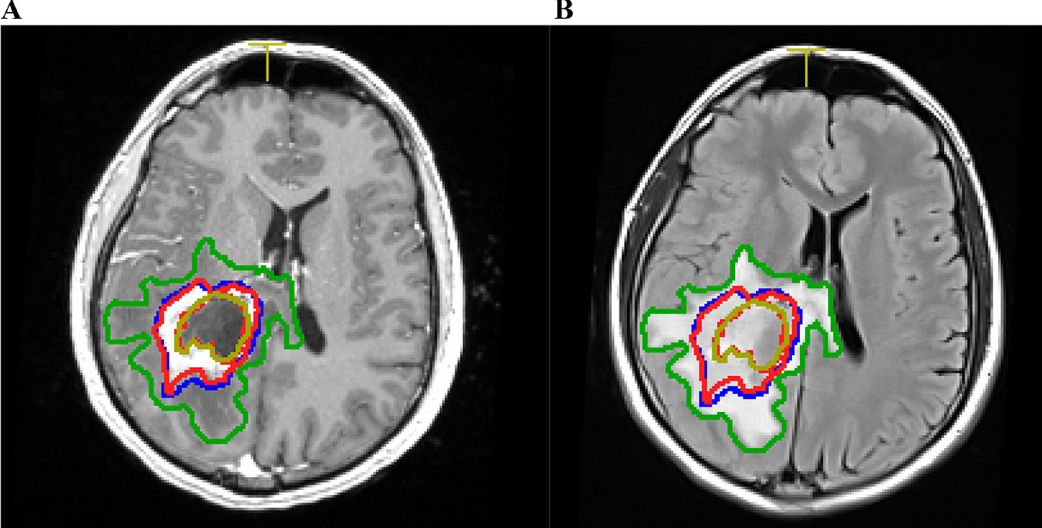
Figure 3. Manual segmentation of the glioblastoma compartments on T1-weighted contrast-enhanced MRI and T2-Flair MRI sequences. GTV (gross target volume) in blue, CE (contrast-enhanced region) in red, NEC (necrosis areas) in yellow, FLAIR in green in axial slice of ( A ) T1-weighetd contrast-enhanced MRI sequence, ( B ) T2-Flair MRI